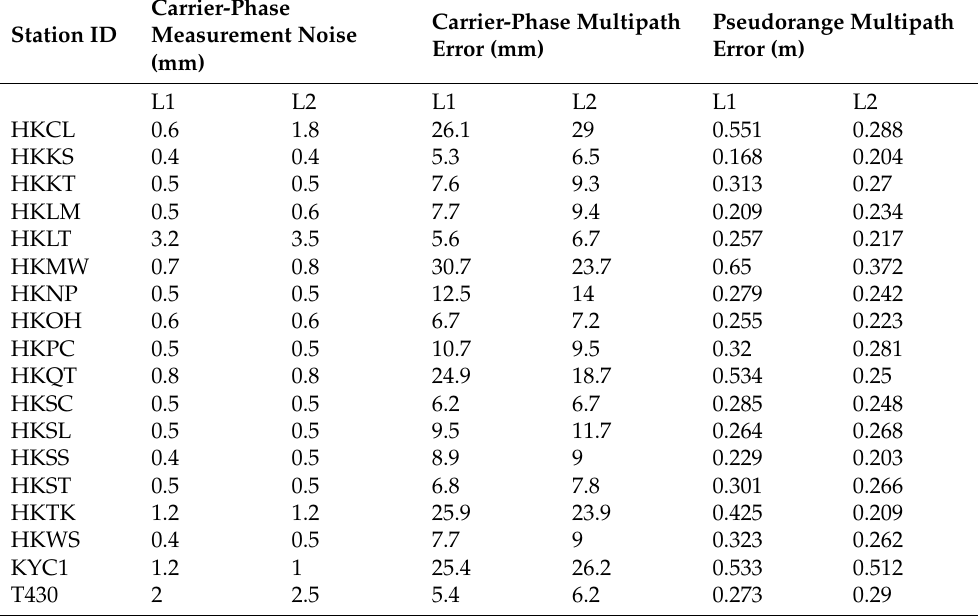
Table A2. Carrier-phase measurement noise, pseudorange, and carrier-phase multipath errors of the Hong Kong SatRef GLONASS dual-frequency measurements at a 95% confidence